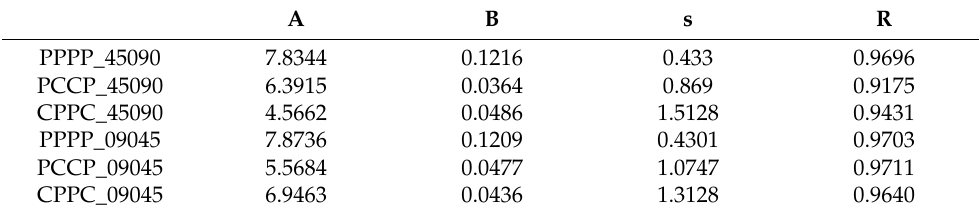
Table 6. Fitted data for the Wöhler’s law parameters and the linear regression